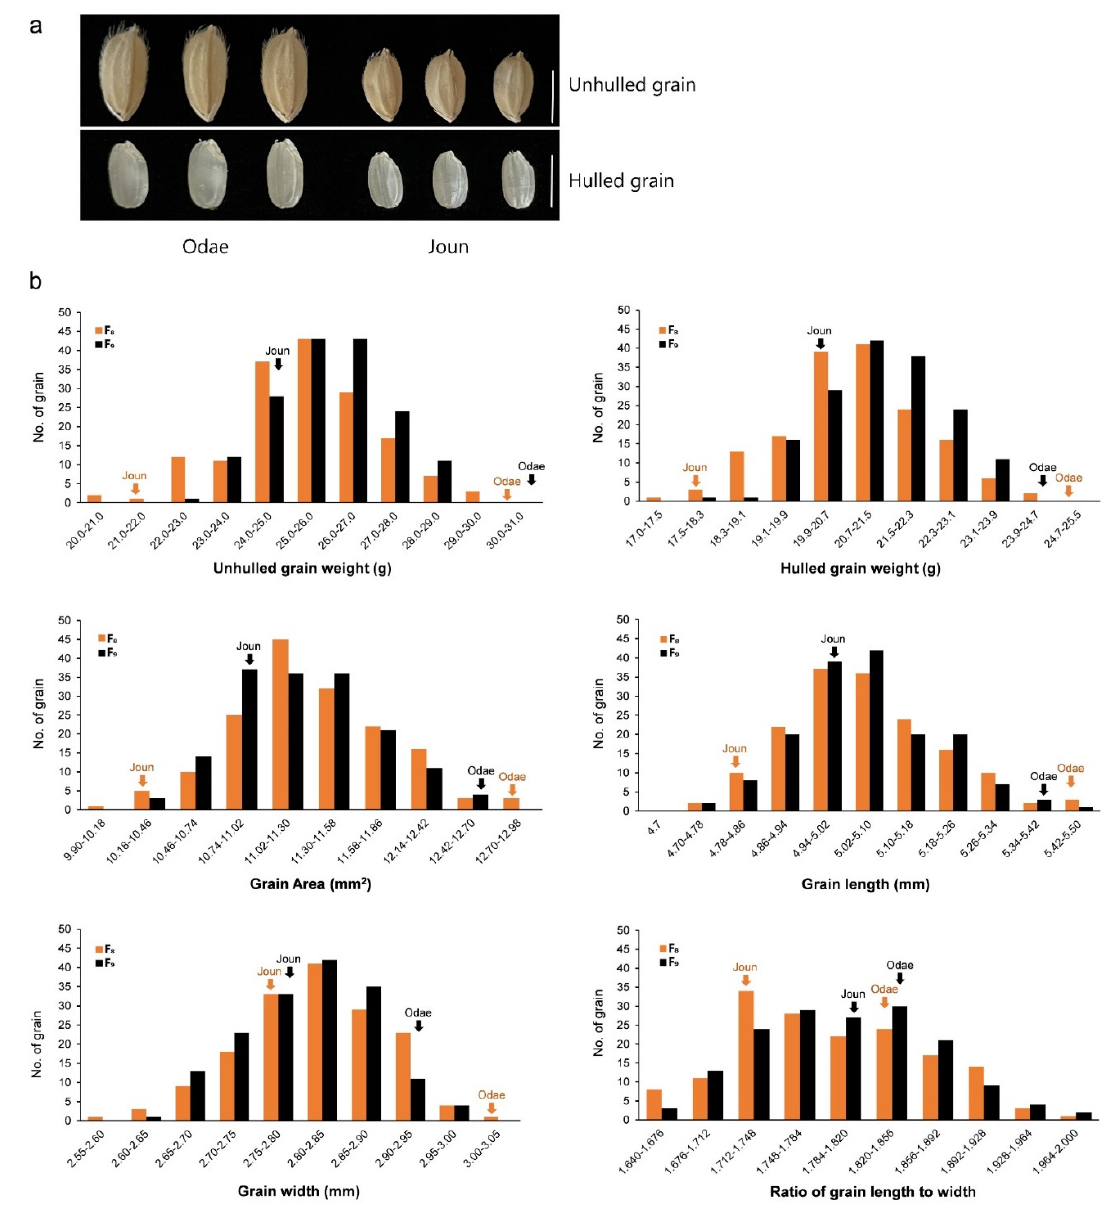
Figure 1. Comparison of parental genotypes and frequency distributions of grain size-related traits in RIL population. ( a ) Grain phenotypes of parental rice varieties, Odae and Joun. Scale bar, 5 mm. ( b ) Frequency distributions of six grain size-related traits in F 8 and F 9 RIL populations (each comprising 162 lines), and two parental varieties Odae and Joun grown in 2019 and 2020. Solid arrows above the histograms indicate the frequencies of parental varieties. F 8 : F 8 RIL population grown in 2019; F 9 : F 9 RIL population grown in 2020; No.: number.